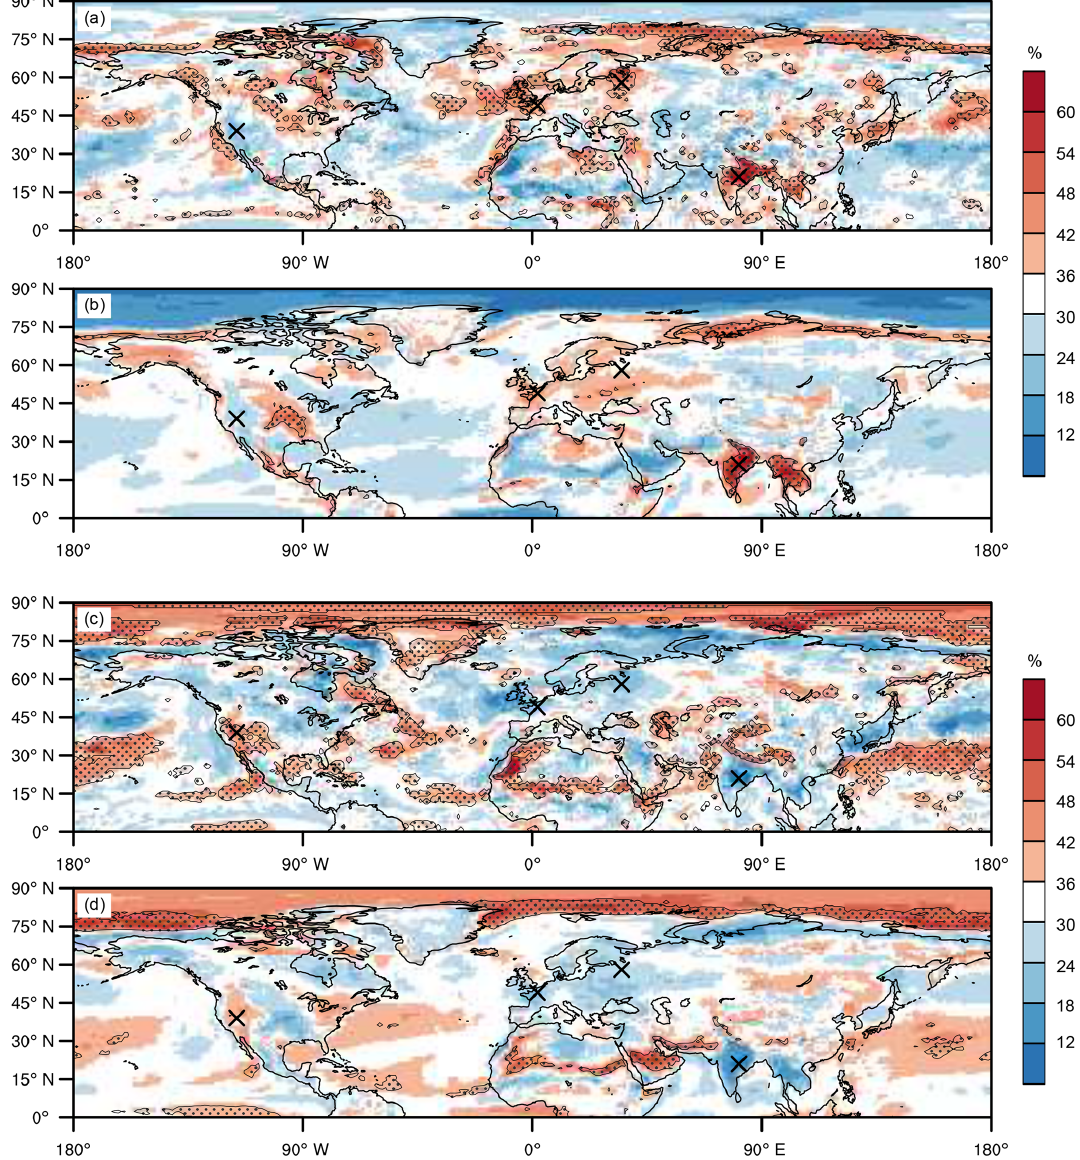
Figure 5. Spatial variability in the extreme-summer substructure in ERA-Interim and CESM. Panels (a) and (b) depict XF ERAI respectively, while XF ERAI and XF CESM are shown in panels (c) and (d) . Stippled areas in all panels indicate grid points at which the same cold cold third of the distribution contributes the largest fraction of all thirds to at least 80% of the extreme summers (i.e. similar substructure in at least 80% of the extreme summers). Black crosses as in Fig.